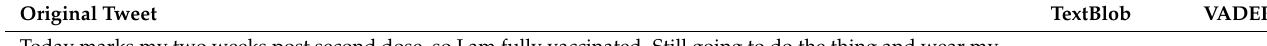
Figure 8. Public Sentiment for Twitter Dataset 2 on Healthy Lifestyle with Timeline using VADER Figure 11. Public sentiment for Twitter Dataset 2 on healthy lifestyle with timeline using VADER.